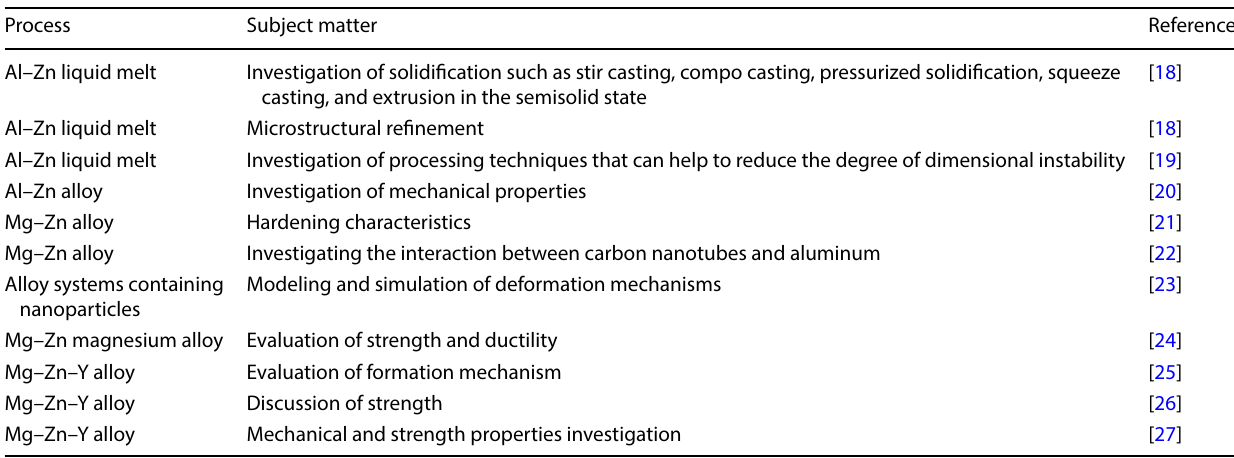
Table 1 Papers related to modeling chemical processes